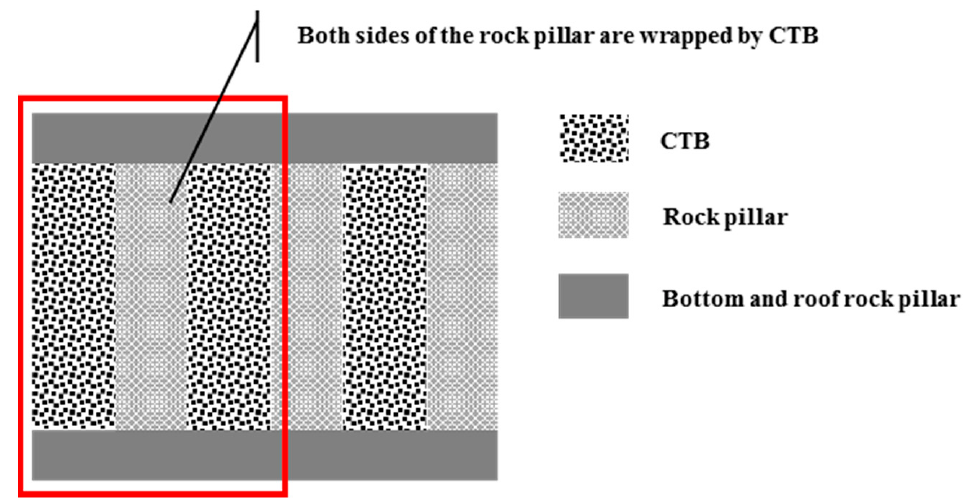
Figure 1. The structures of both sides of the rock pillar are wrapped by CTB in the underground metal mines using SSOBMM.